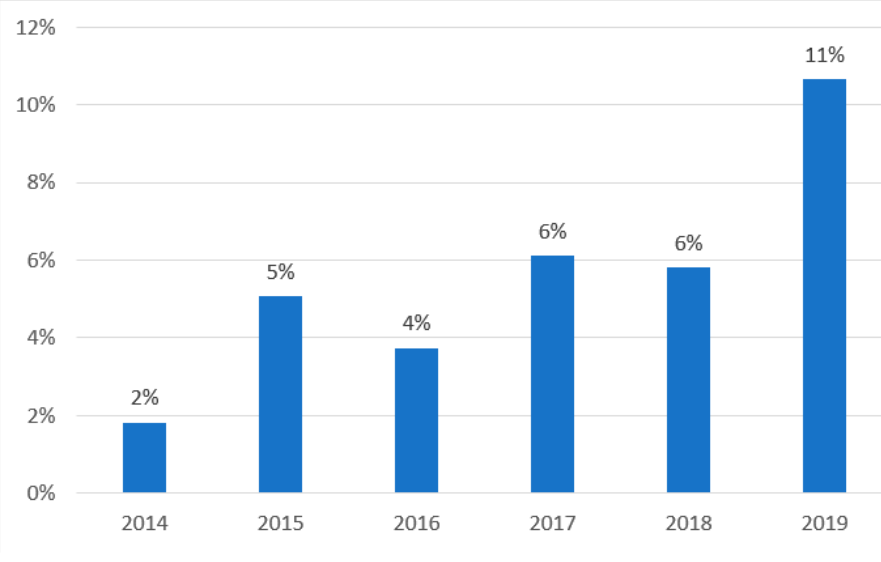
Figure 2. Percentage of admissions from total cohort by year.